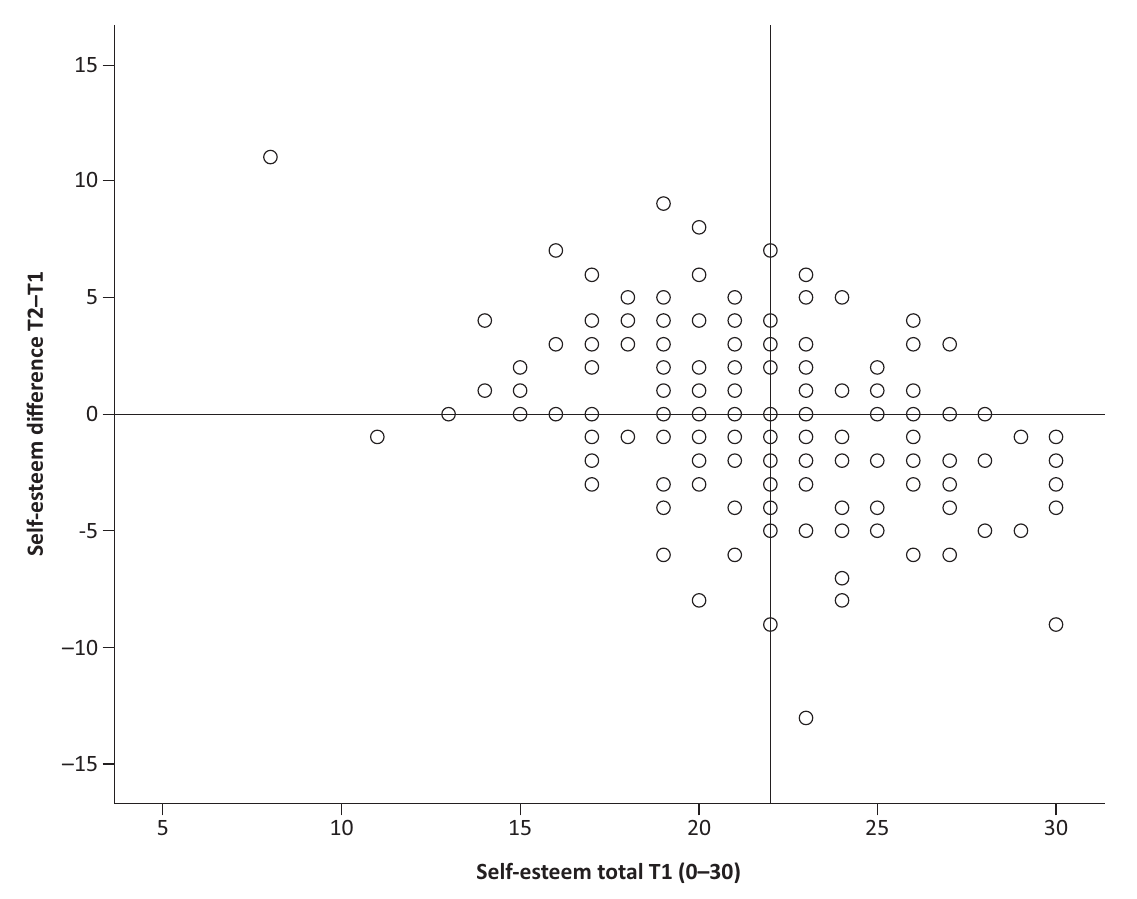
Figure 5. Scattergrams of individual self-esteem